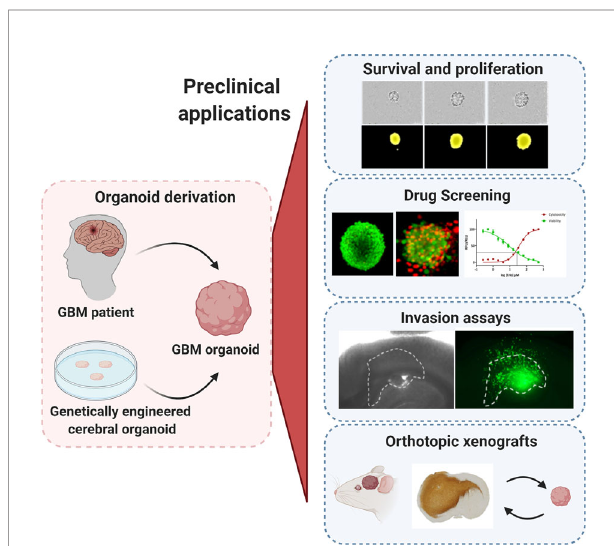
FIGURE 1 | Preclinical applications of GBM organoids. GBM organoids derived from patient tumors or from genetically engineered cerebral organoids can be applied for numerous functional assays such as: tumor cell survival, proliferation and self-renewal, drug screening, ex vivo invasion assays, and derivation of orthotopic xenografts. All experimental images were acquired by the authors. Illustration created with Biorender.com.